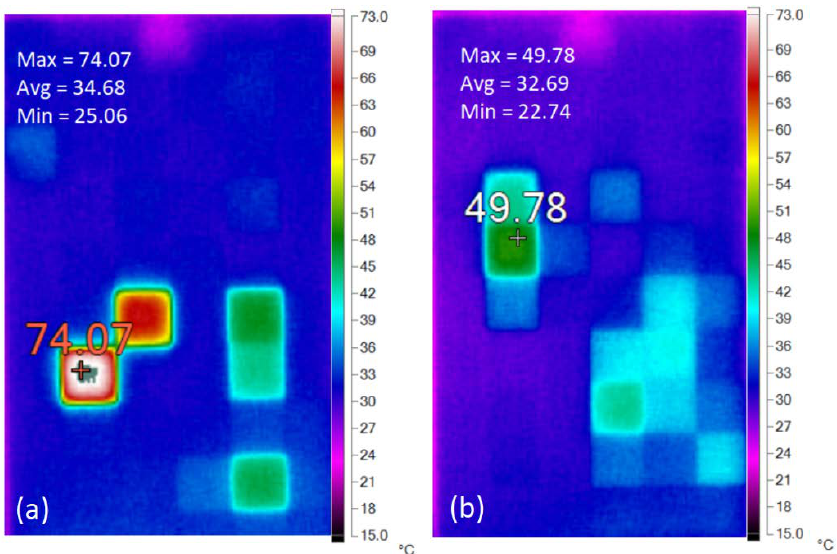
Figure 4. Images obtained with an infrared thermal camera. ( a ) Discarded module with hot areas; and ( b ) selected module without hotspots.